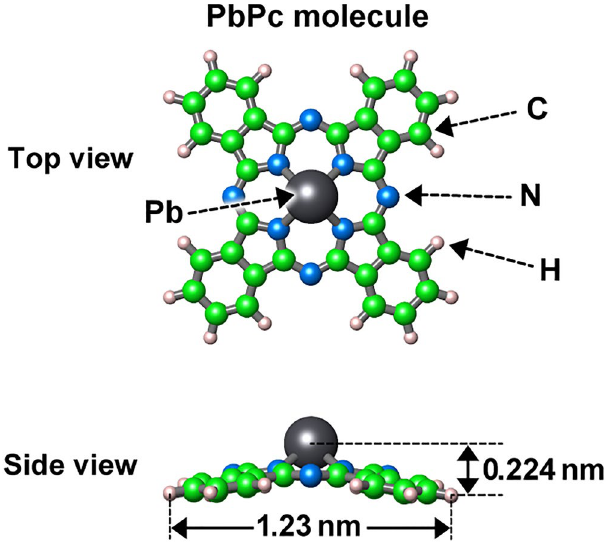
Figure 1. Schematic illustration of the top and side views of the PbPc molecule.